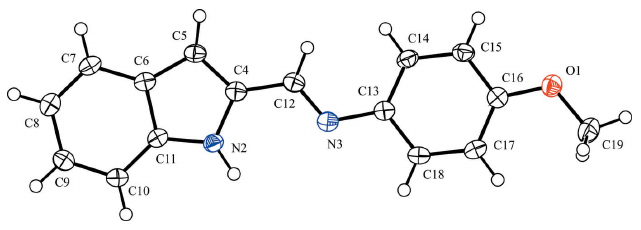
Figure 1 The molecular structure of the title compound with atom labelling. Displacement ellipsoids are drawn at the 50% probability level. H atoms are represented by spheres of arbitrary